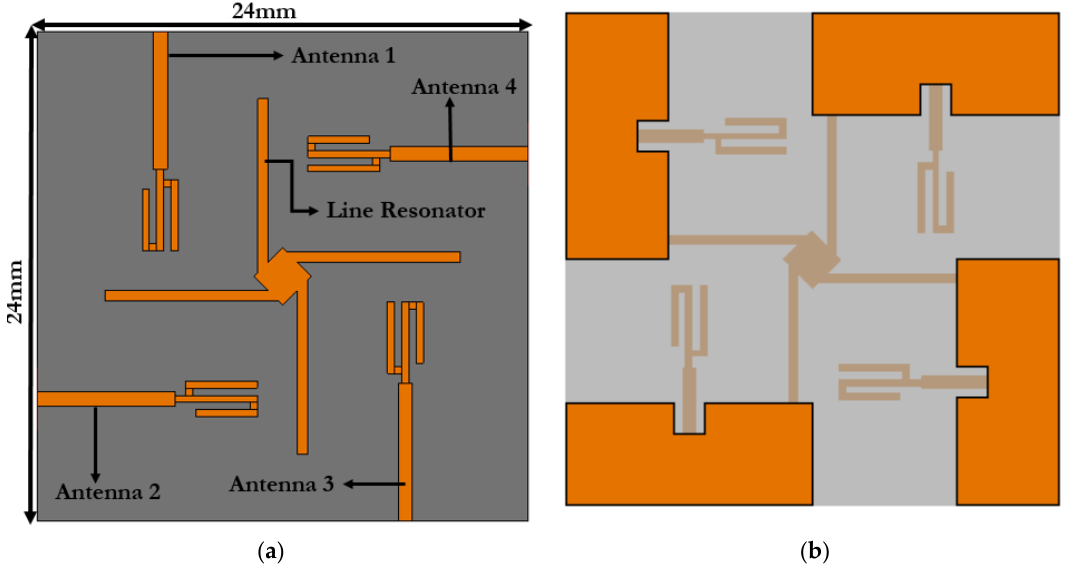
Figure 5. MIMO Antenna ( a ) Front ( b )